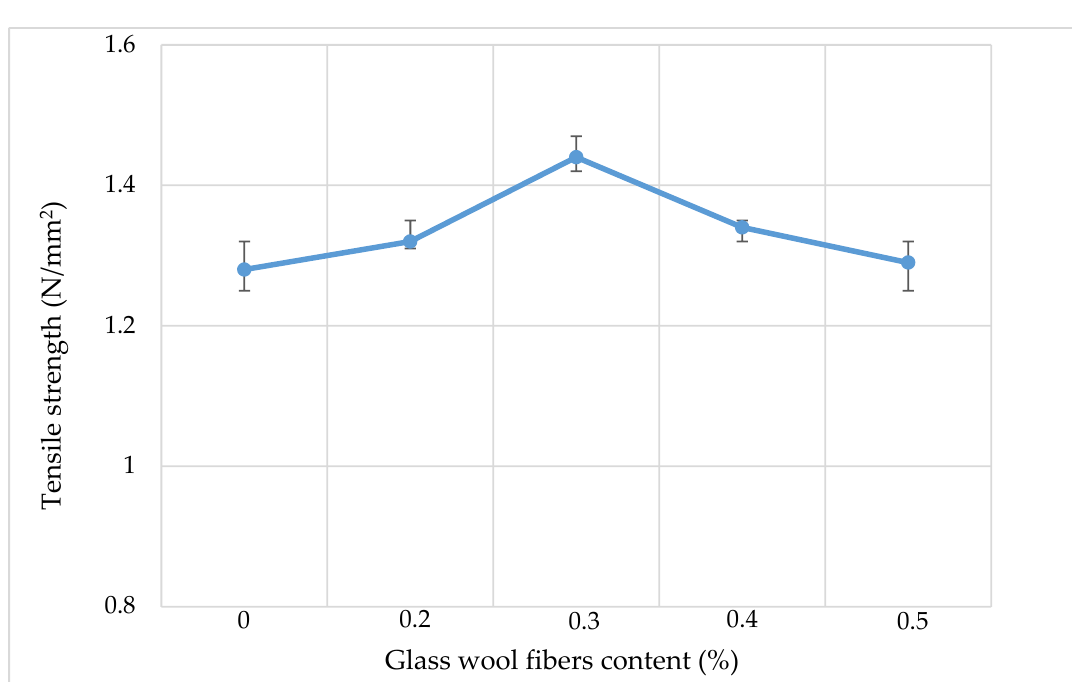
Figure 8. Tensile strength results .